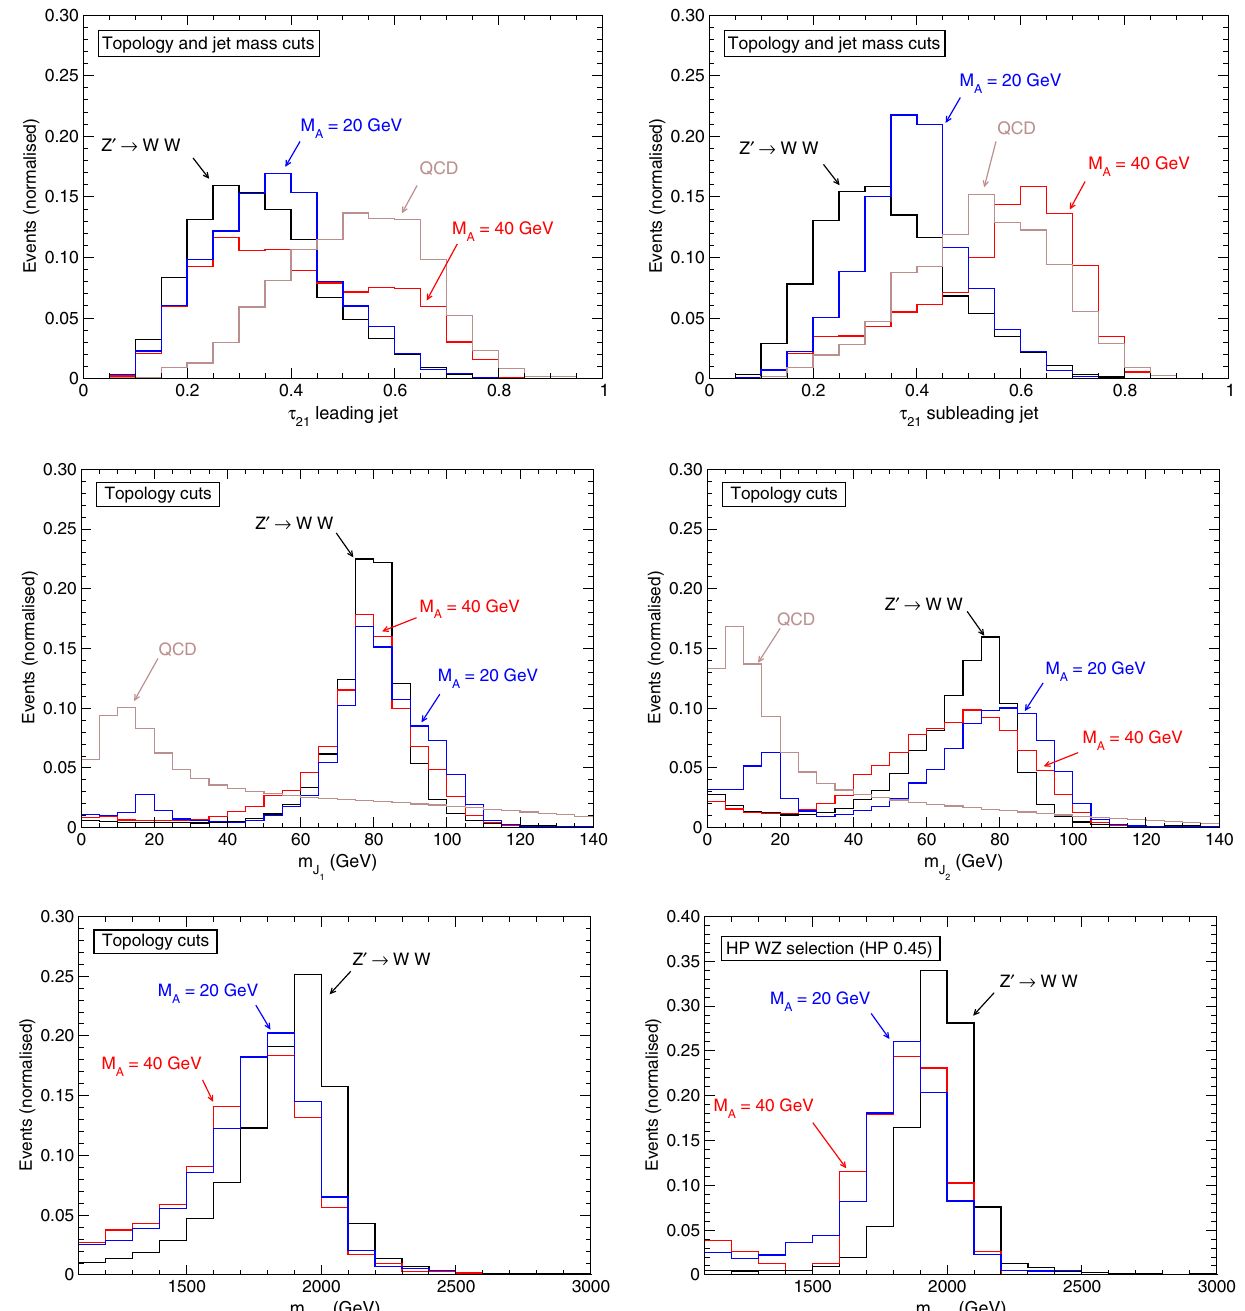
Fig. 9 Distributions for the R → V S and Z (cid:8) → WW signals and the QCD dijet background in the CMS analysis. Top: N -subjettiness ratio τ 21 ; middle: jet mass distributions; bottom: dijet mass distributions